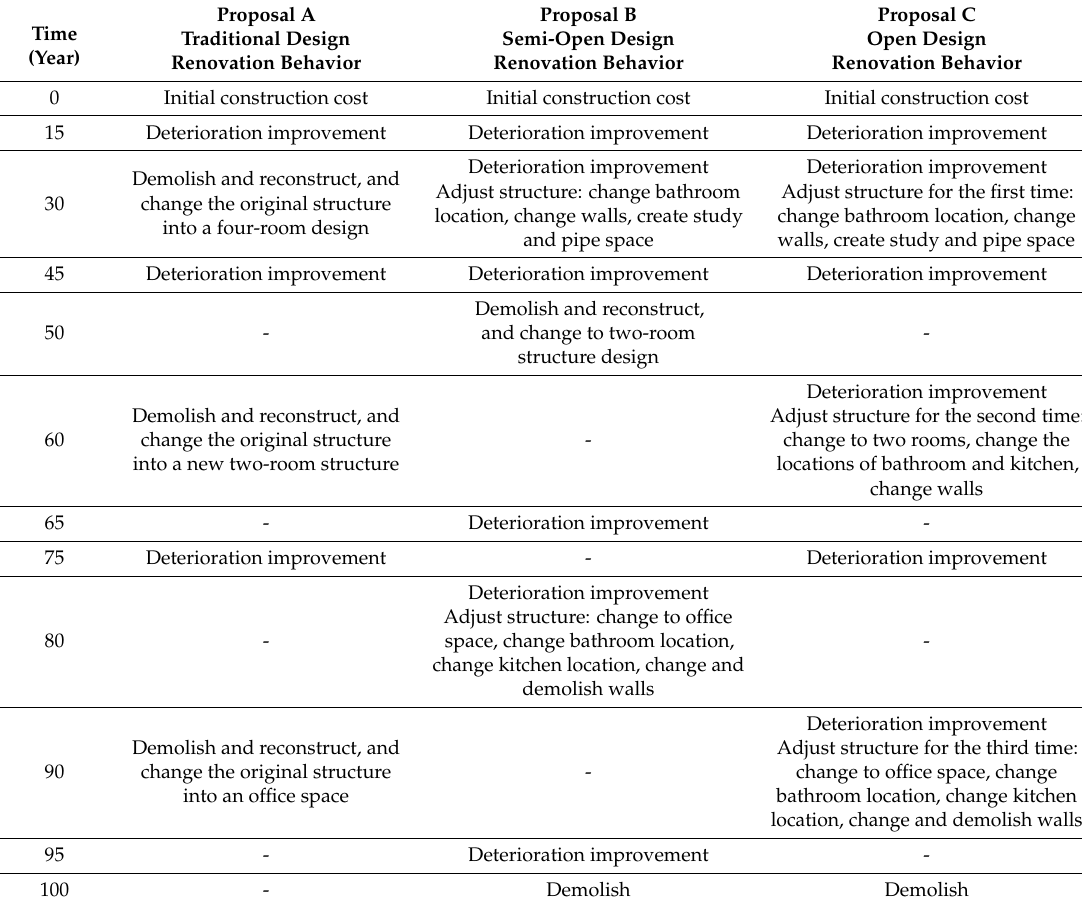
Table 1. Renovation behavior analysis in the life cycles of the three proposals.